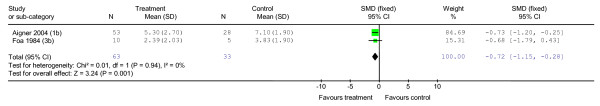
Meta-analysis of work-related effect of net contribution of exposure in vivo based on two OCD studies.